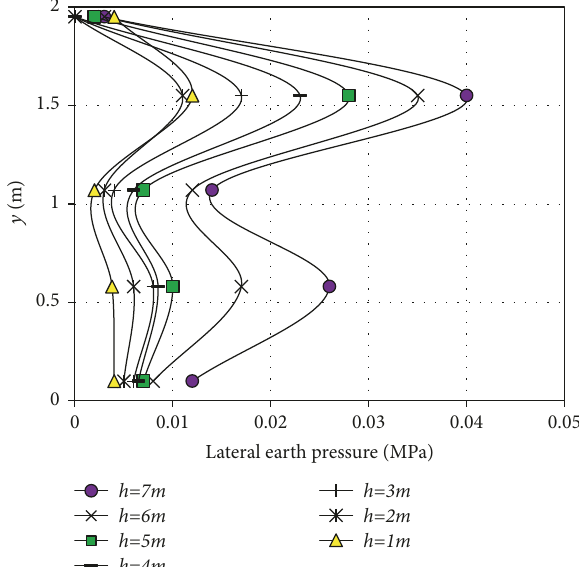
Figure 8: Distribution of lateral pressure on the right wall of section II.